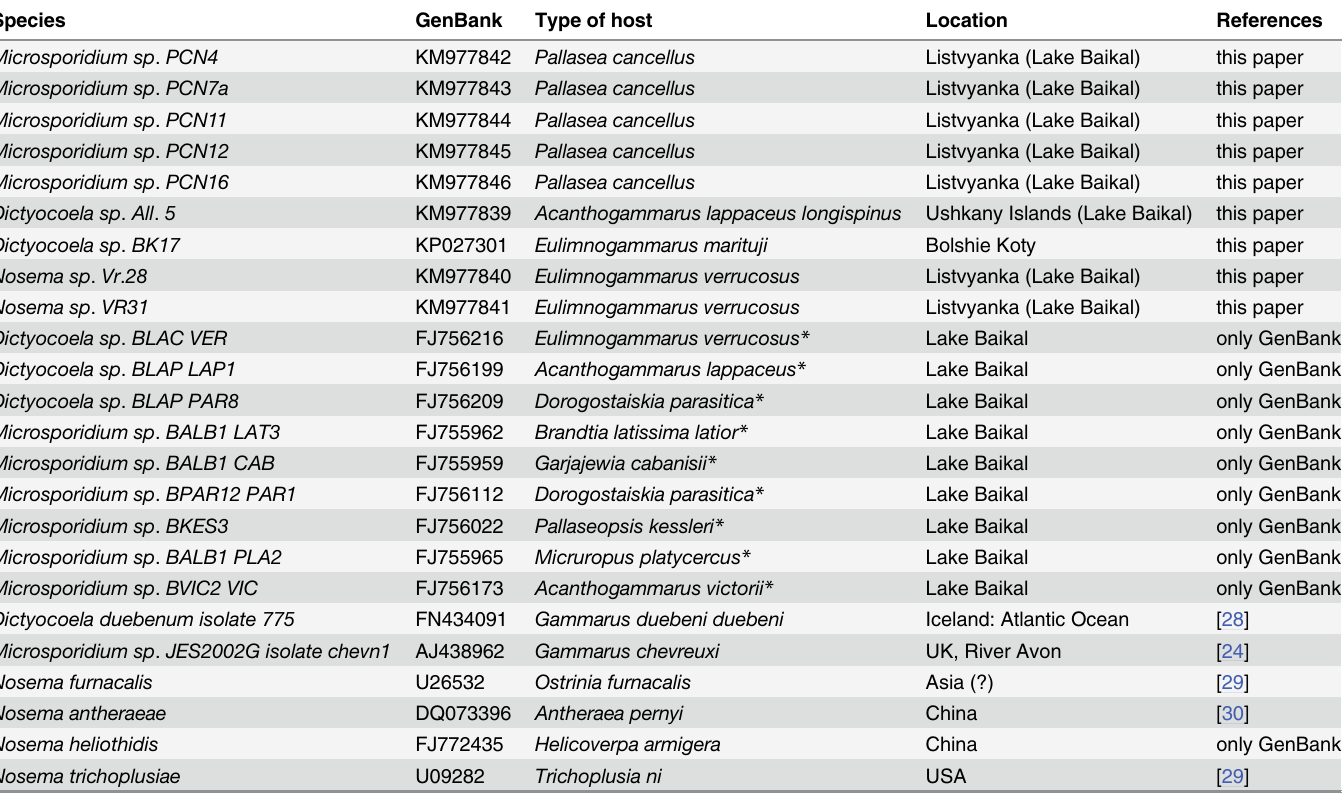
Table 1. The SSU rDNA sequences of microsporidia used for phylogenetic